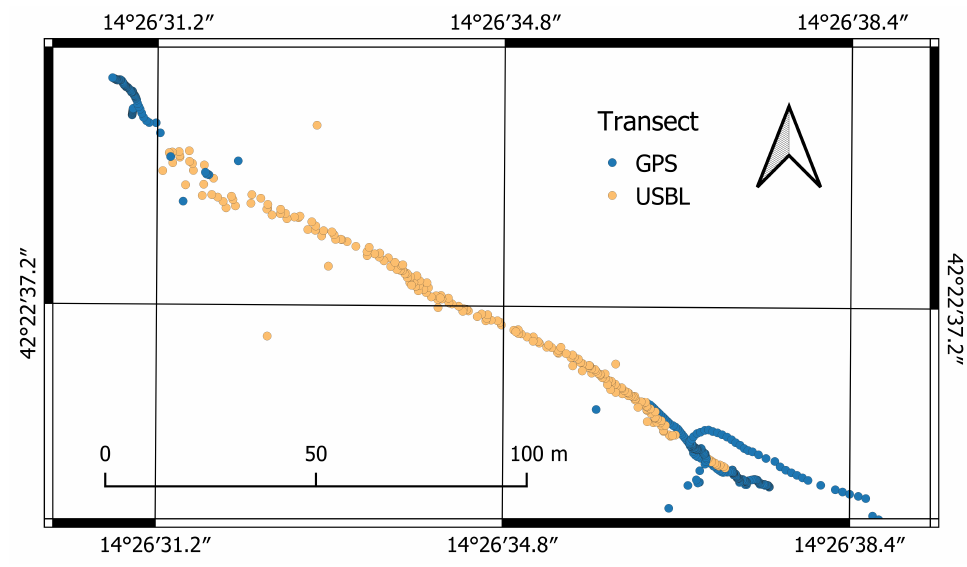
Figure 12. Transect performed by UUV partially above and partially under water